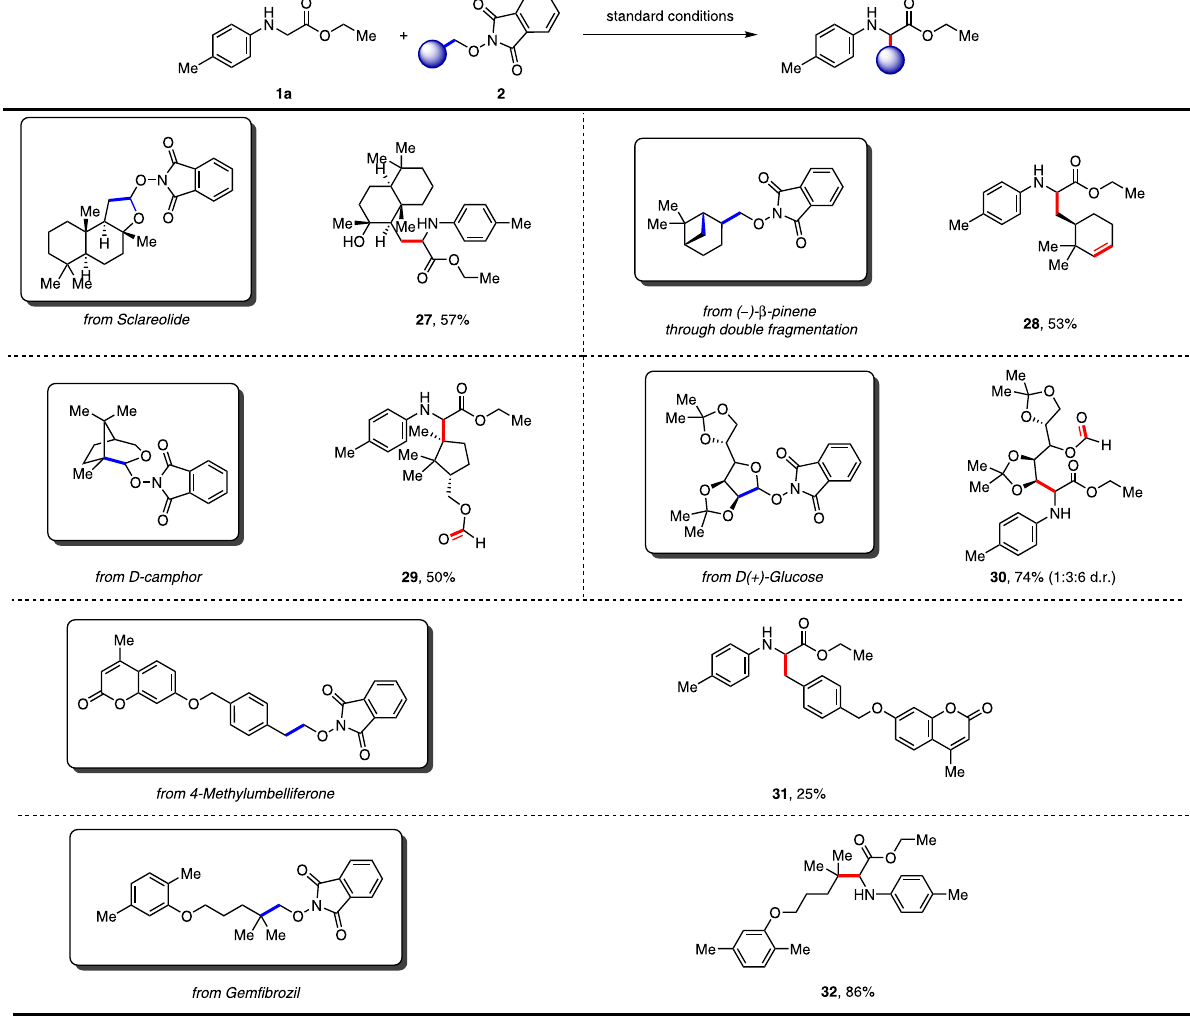
Fig. 3 | N -alkoxyphthalimides from nature sources. Conditions: All reactions were carried out with 4CzIPN (5mol%), 1a (0.2mmol), 2 (0.1mmol), and DMSO (0.03M) irradiated under 15W Blue LEDs at